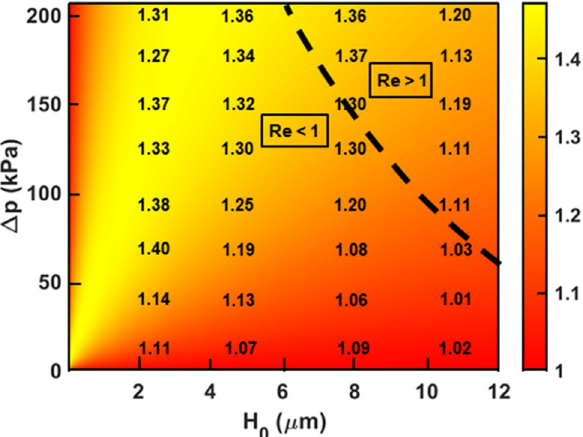
Figure 3. The rectification ratio ( η ) contour plot obtained from the coupled fluid–solid-mechanics model for a DI water flow through the nozzle/diffuser microchannels with the widths of 1 mm and 2 mm. The tabulated values are the experimental results noted from Fig. 2 at the corresponding ( H 0 , (cid:31) p ). The dotted line indicates the conditions where the averaged Reynolds number at the midplane ( x ∗